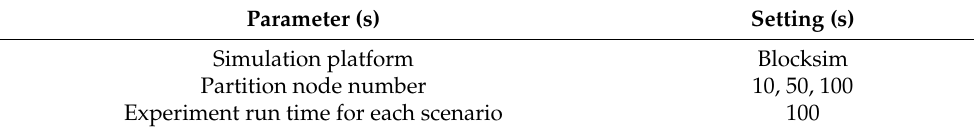
Table 3. Parameters in experiment 1.